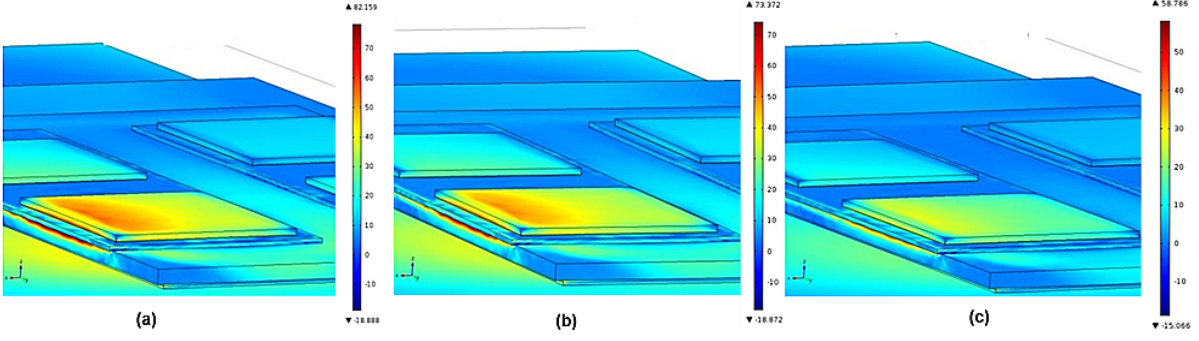
Figure 15. Surface first principle stress for FS based back-to-back (BTB) converter’s generator side power module with ( a ) fixed DC link; ( b ) dynamic DC link without and ( c ) with switching frequency